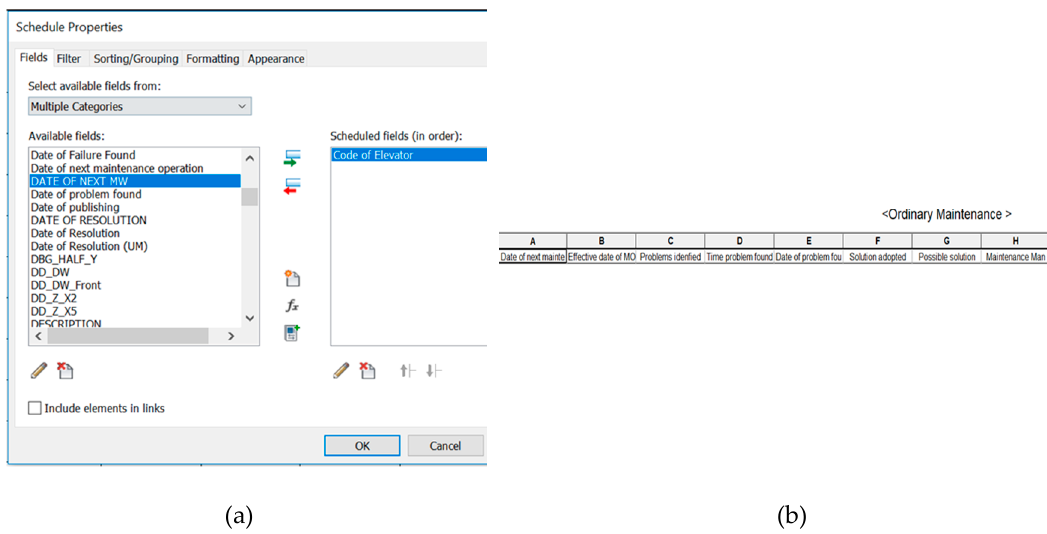
Figure 6. ( a ) Revit abacus implementation; ( b ) list of fields included in the abacus concerning ordinary maintenance operations (excerpt).